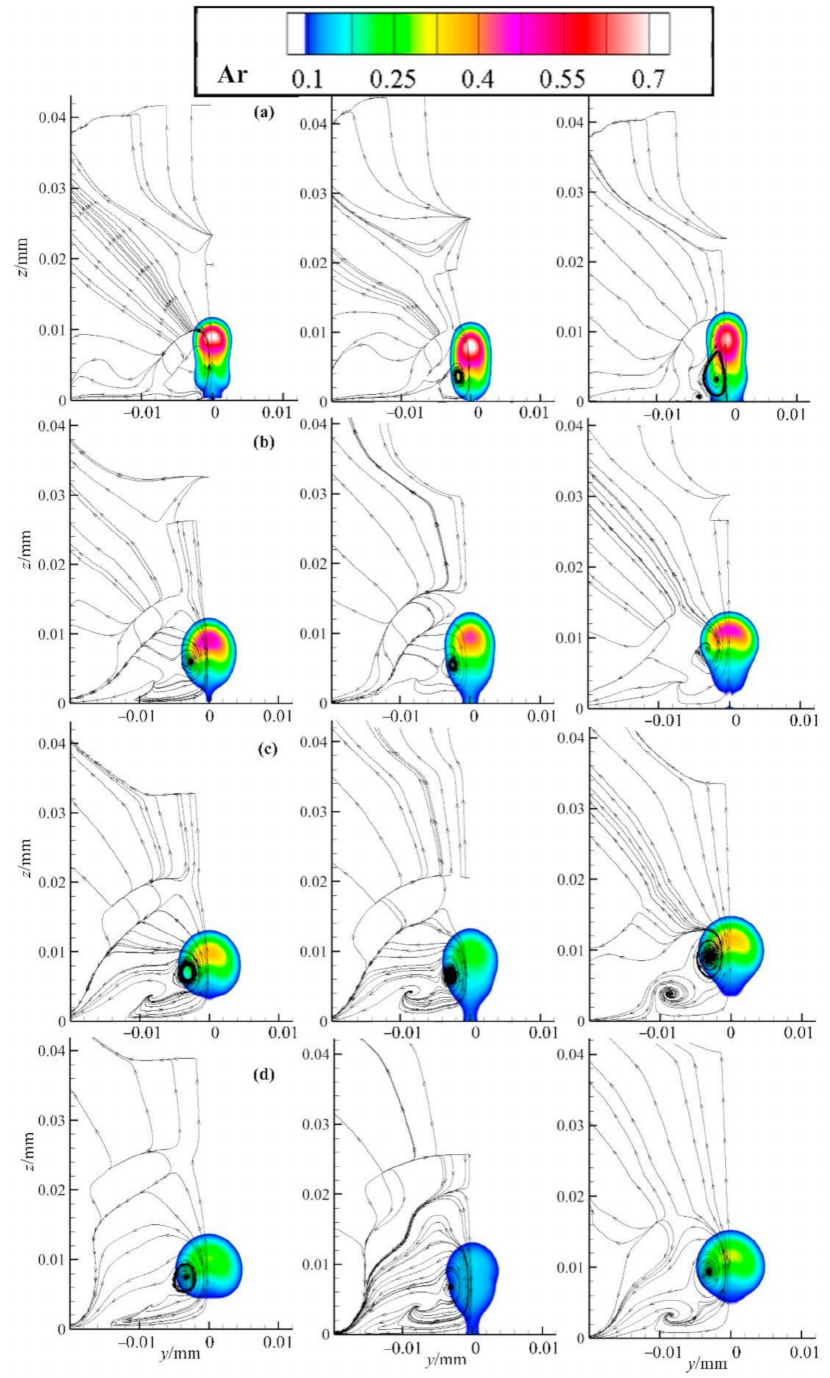
Figure 11. Mass fraction contours and streamline diagram of Case a, Case b, and Case c at x = ( a ) 30, ( b ) 60, ( c ) 90, and ( d ) 120